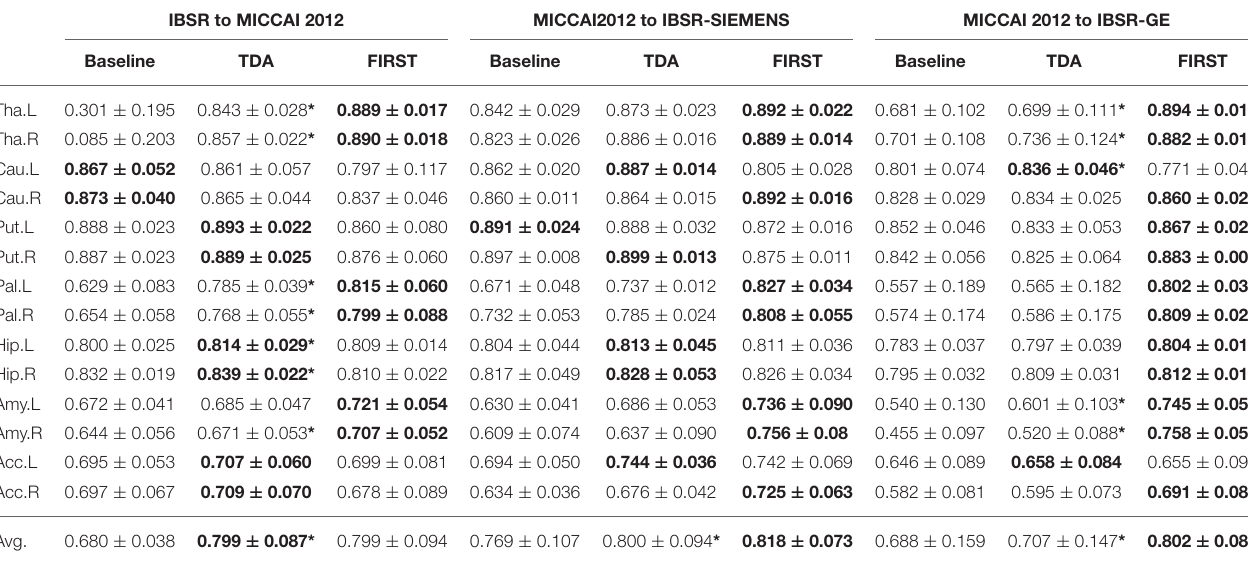
TABLE 1 | DSC results with standard deviations for the pre-trained baseline model without domain adaptation, transductive domain adaptation (TDA), and unsupervised FIRST method for two-way validation: from IBSR to MICCAI 2012; from MICCAI 2012 to IBSR-SIEMENS; and from MICCAI 2012 to